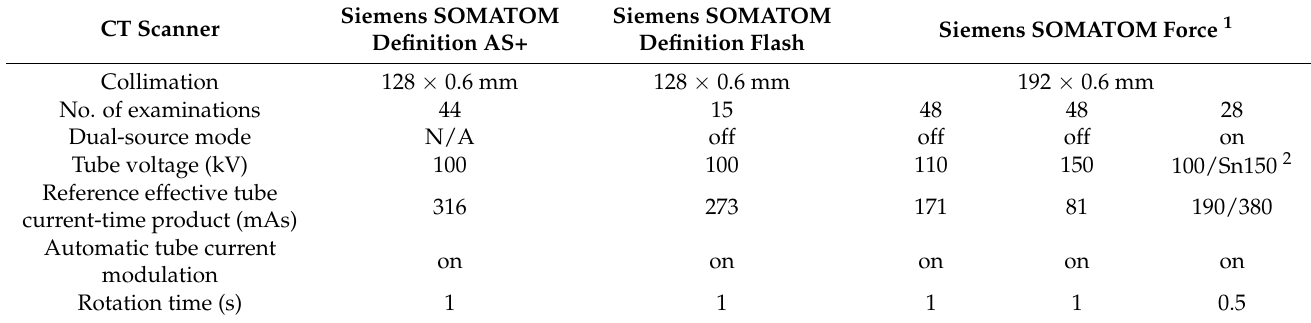
Table 1. Technical parameters of CT myelography at three different multi-slice CT scanners.